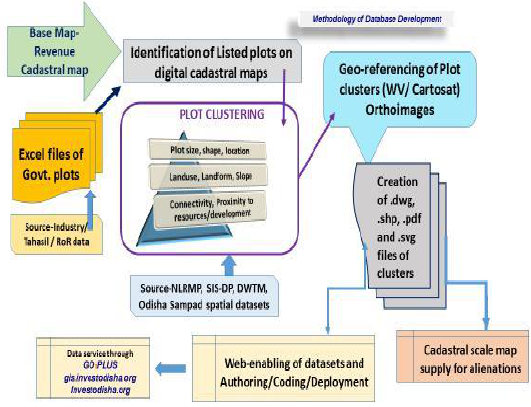
Figure 1. Methodology of Land Bank Preparation